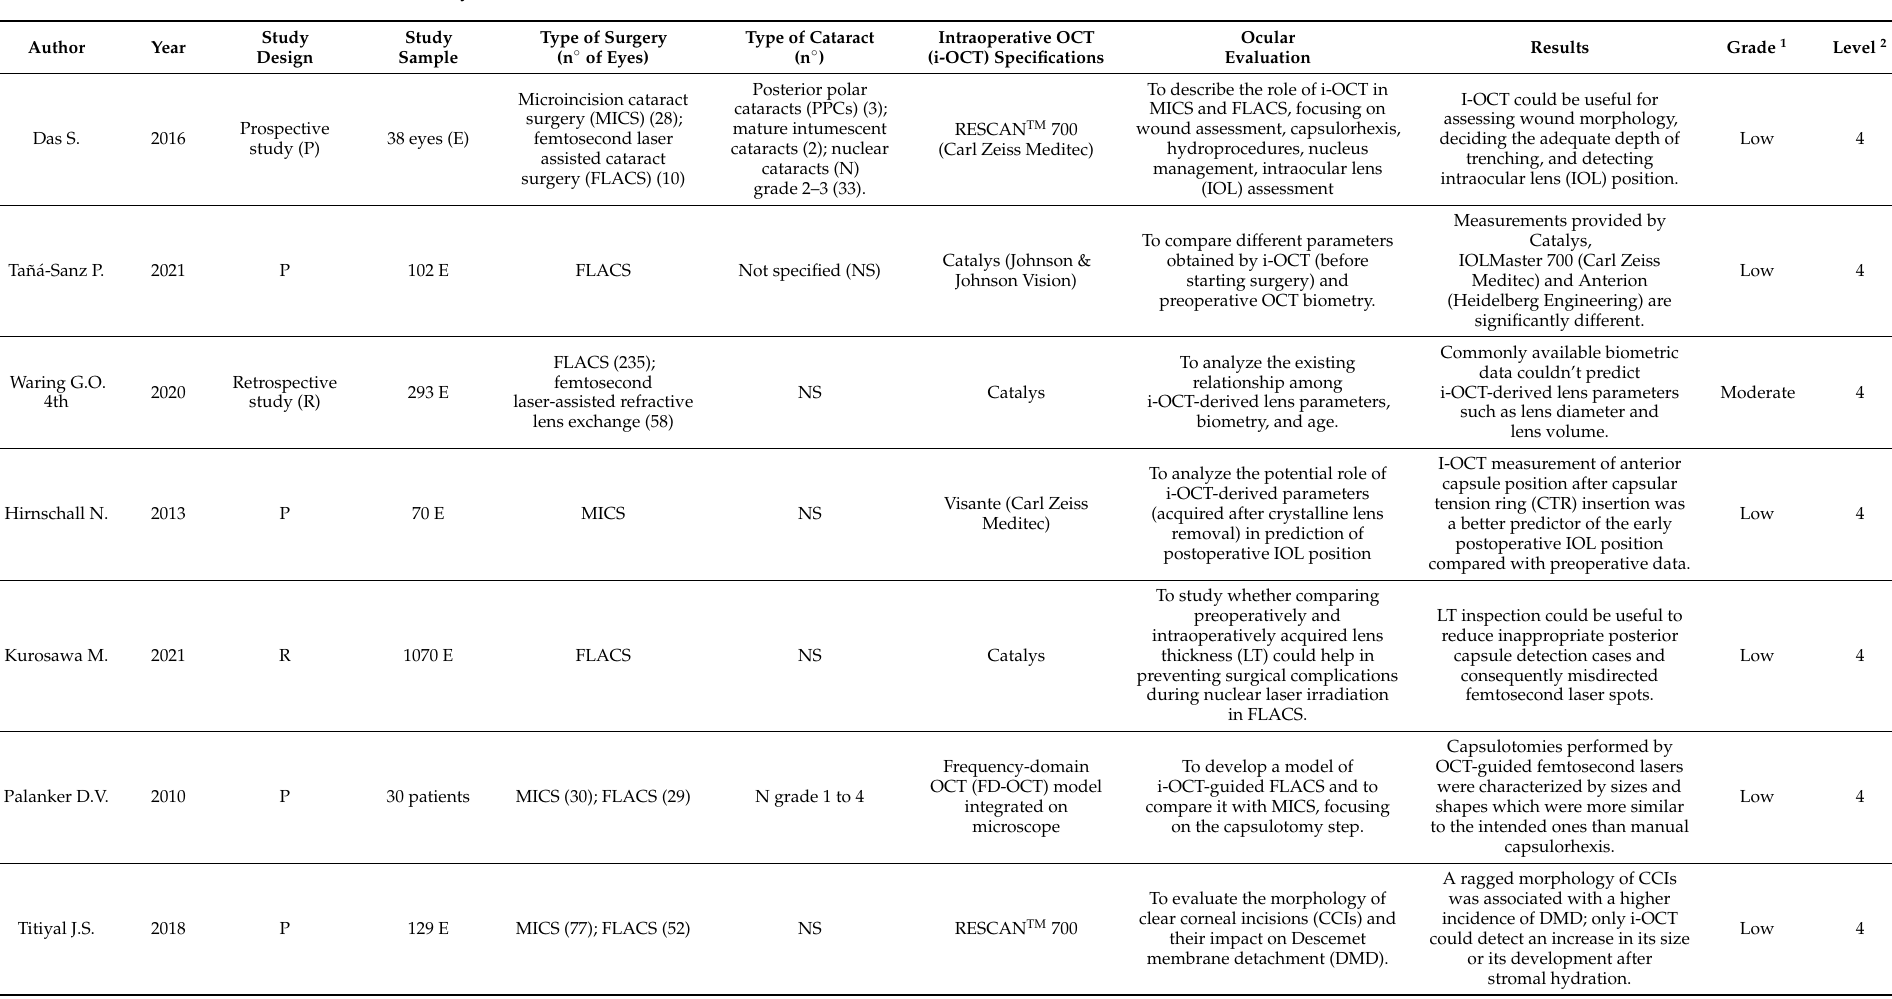
Table 1. Characteristics, quality, and level of evidence of the included studies and features of the anterior segment intraoperative optical coherence tomography (i-OCT) cited by these